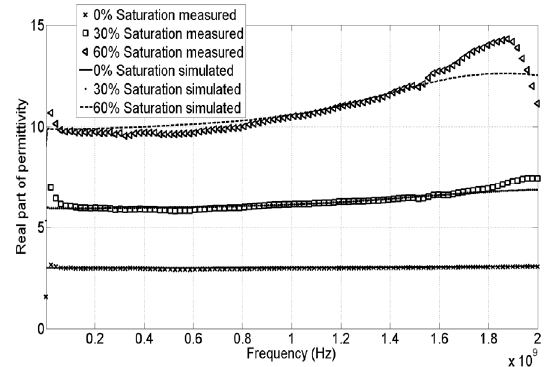
Figure 14. Real part of the permittivity measured (lines) and calculated (dots) for different